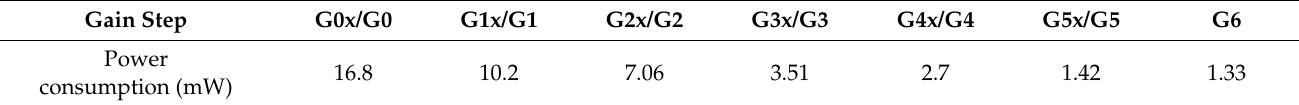
Figure 8. Top layout of the chip, proposed LNA and location of the ESD protection and RX switch at the input, attenuator, LNA-core, voltage generator, and capacitor bank. Table 6. Summary of power consumption for all gain